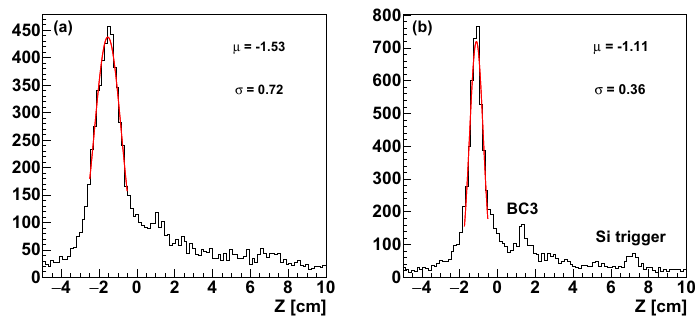
Figure 7. Distribution of z coordinate of the primary vertex before (a) and after (b) the alignment. The used data are recorded without a magnetic field